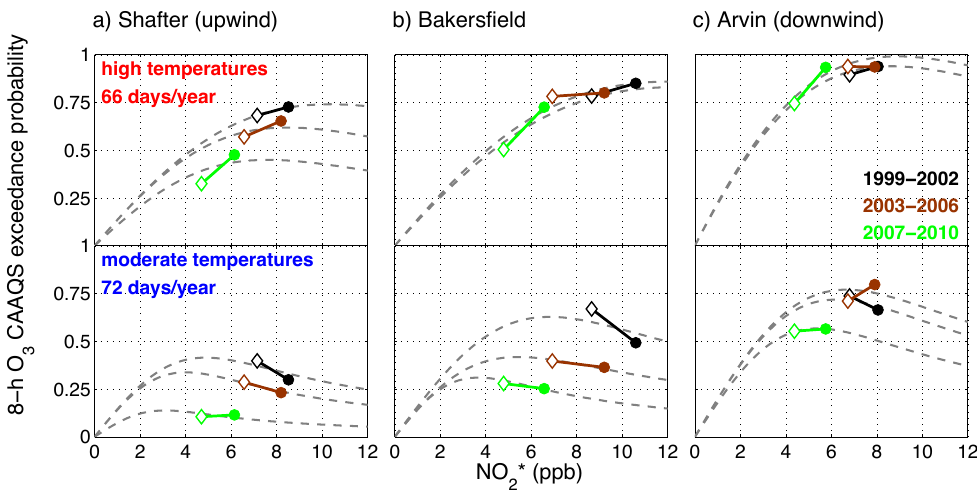
Fig. 6. Southern SJV four-year median 8-h O 3 CAAQS exceedance probabilities vs. NO 2 * tethering weekday (circles) and weekend (di- amonds) conjugates for 1999–2002 (black), 2003–2006 (brown), and 2007–2010 (green). Data are shown separated by high- (top) and moderate- (bottom) temperature regimes for Shafter (a) , Bakersfield (b) , and Arvin (c) . Uncertainties in the probability of violations (by counting statistics) are typically less than ± 0.04 (1 σ) for weekdays and ± 0.06 (1 σ) for weekends. Curves (dashed grey lines) are included for visual aid and are not meant to be quantitative; the lines were generated with an analytical model where only VOCR was tuned and P O 3 was then scaled to fit.